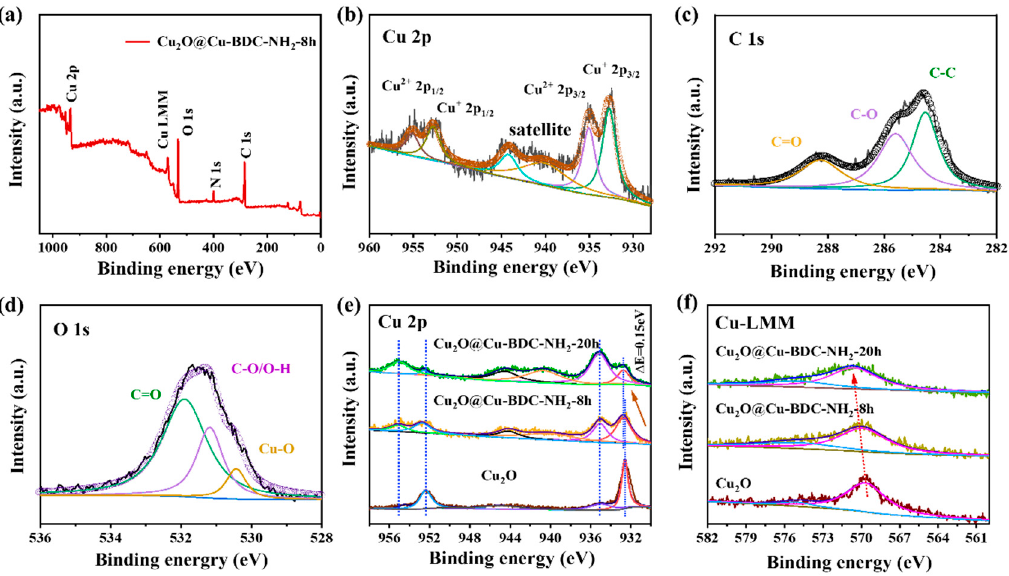
Figure 3. ( a ) XPS survey, ( b ) Cu 2p, ( c ) C 1s, ( d ) O 1s spectra of Cu 2 O@Cu-BDC-NH 2 -8h. ( e ) Cu 2p and ( f ) Cu-LMM XPS spectra of Cu 2 O, Cu 2 O@Cu-BDC-NH 2 -8h, and Cu 2 O@Cu-BDC-NH 2 -20h.